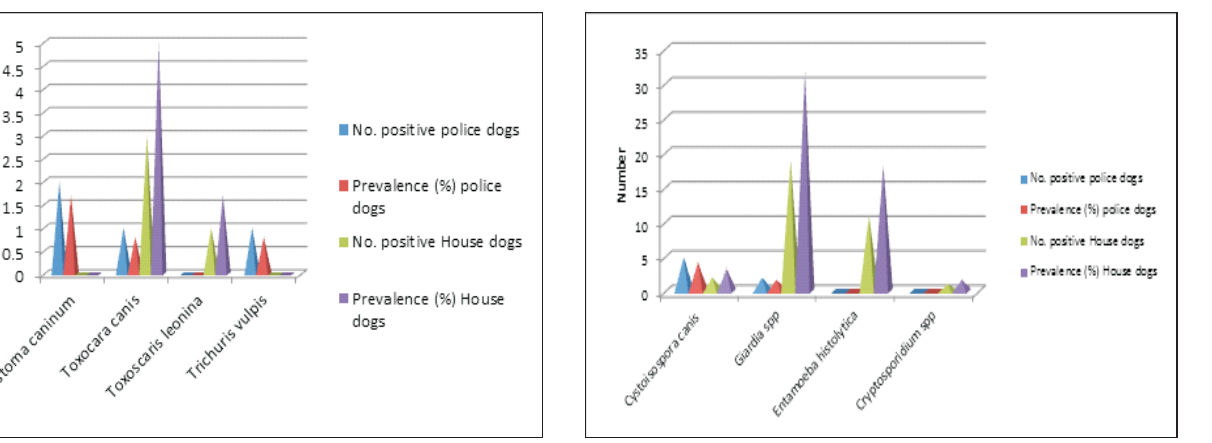
Figure-2: Prevalence of enteric protozoa species detected in police and house dogs.